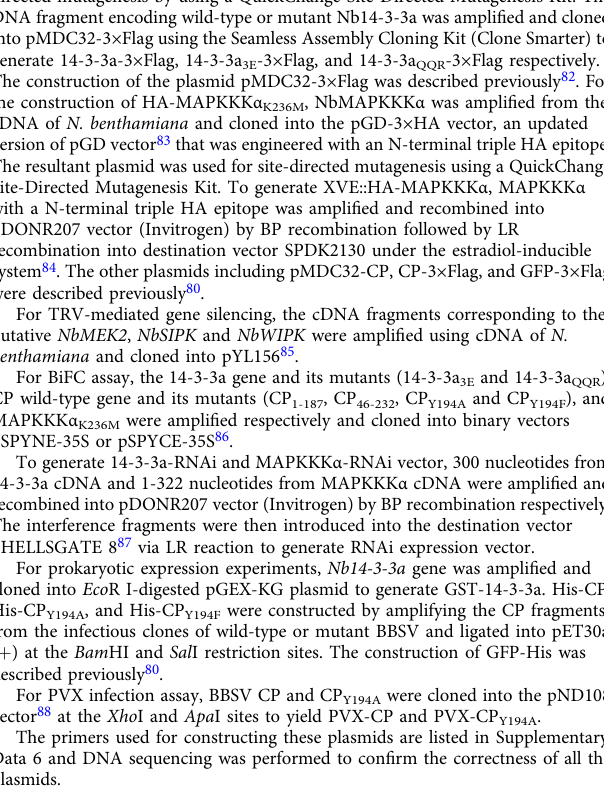
Fig. 9 Perturbation of Nb14-3-3a-MAPKKK α functional module by the CP is a common strategy employed by necroviruses. a , b BiFC analysis of the interaction between CP of TNV-A C ( a ) or TNV-D H ( b ) and 14-3-3a. The indicated combinations of different proteins were transiently co-expressed in N. benthamiana leaves. Confocal analysis was performed at 3 dpi. The experiments were repeated three times and representative results are shown. Scale bars = 50 µ m. c , d CP inhibits MAPKKK α -induced cell death. Agrobacterium carrying wild-type TNV-A C ( c ) or TNV-D H ( d ) CP or their variants was co- in fi ltrated with Agrobacterium containing HA-MAPKKK α controlled by an estradiol-inducible system into different leaf regions. Empty vector (EV) served as the negative control. β -estradiol was applied 48 h after agroin fi ltration. Leaves were stained by trypan blue and representative photographs were taken 3 days after estradiol treatment. e , f Quanti fi cation of cell death by measuring electrolyte leakage of leaf regions shown in ( c ) and ( d ). Error bars indicate ± SD of the mean ( n = 6 biologically independent plants). Different letters in the chart denote statistically signi fi cant differences among different groups according to the one-way ANOVA analysis with Tukey ’ s multiple comparison test ( P < 0.05). g , h CP affects MAPKKK α protein stability and MAPK activation in non-transgenic N. benthamiana . Agrobacterium carrying CP or CP Y194A was co-in fi ltrated with Agrobacterium containing HA-MAPKKK α controlled by an estradiol-inducible system into the leaves. Empty vector (EV) served as the negative control. In all, 30 μ M β -estradiol was in fi ltrated into the leaves 48 h after agroin fi ltration. Samples were collected at 0, 12, 24 h after β -estradiol treatment and subjected to western blot with different antibodies indicated on the right. Actin served as the loading control. The experiments were repeated three times with similar results. i , j Phenotype observation of TNV-A C ( i ) or TNV-D H ( j ) -infected MAPKKK α -KO plants. N. benthamiana leaves were inoculated with 100 ng TNV-A C virions. Representative photographs were taken at 9 dpi. k Western blot analysis of TNV-A C CP levels in the plants shown in panel i using an anti-TNV-A C antibody. Actin served as the loading control. The experiment was repeated three times with similar results. l RT-qPCR analysis of TNV-D H genomic RNA levels in the plants shown in panel j . Values represent ± SD of the mean ( n = 6 biologically independent plants). An asterisk indicates the signi fi